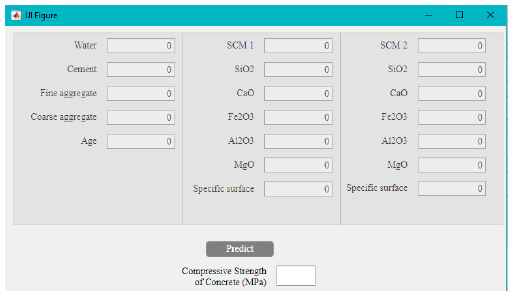
Figure 10. The developed software for predicting the compressive strength of concrete containing binary